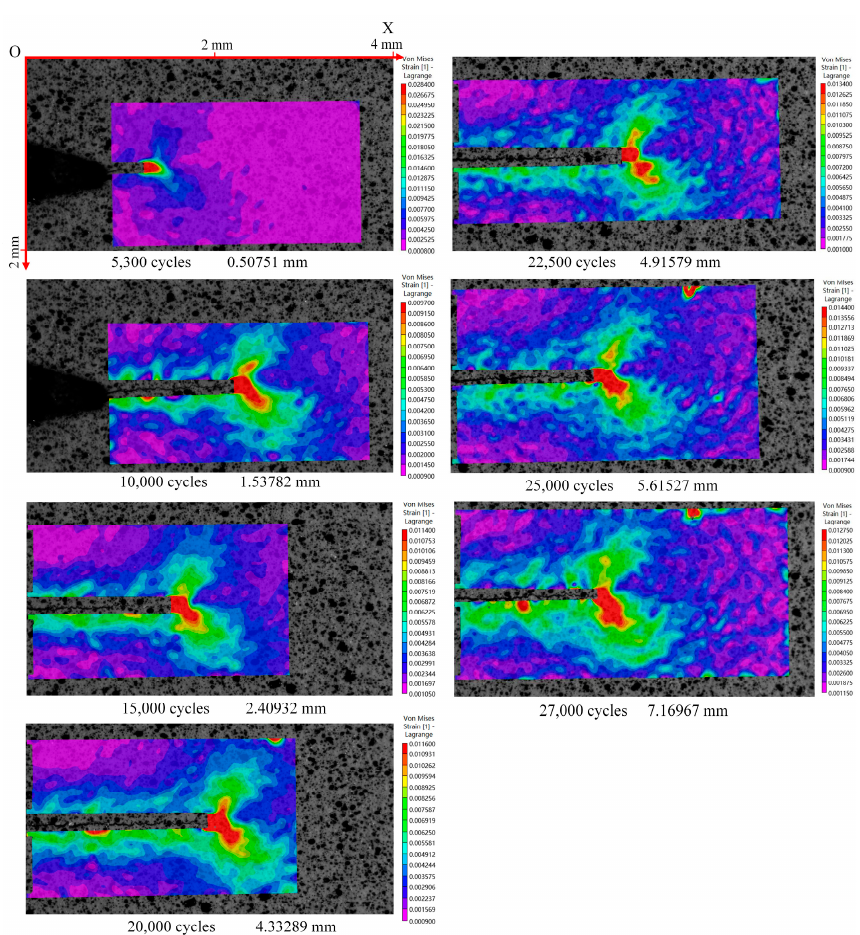
Figure 16. Strain field at maximum load for different numbers of cycles.